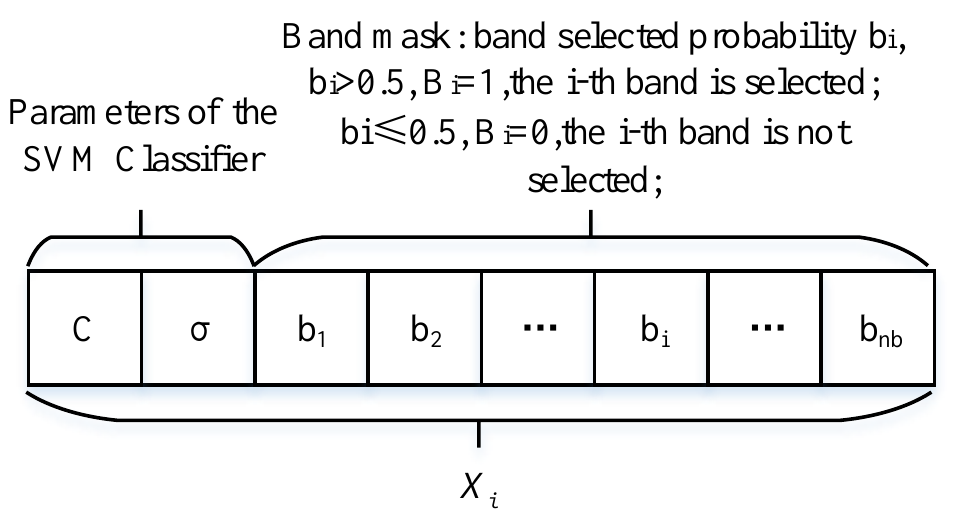
Figure 1. Support vector machine (SVM) optimization parameters.